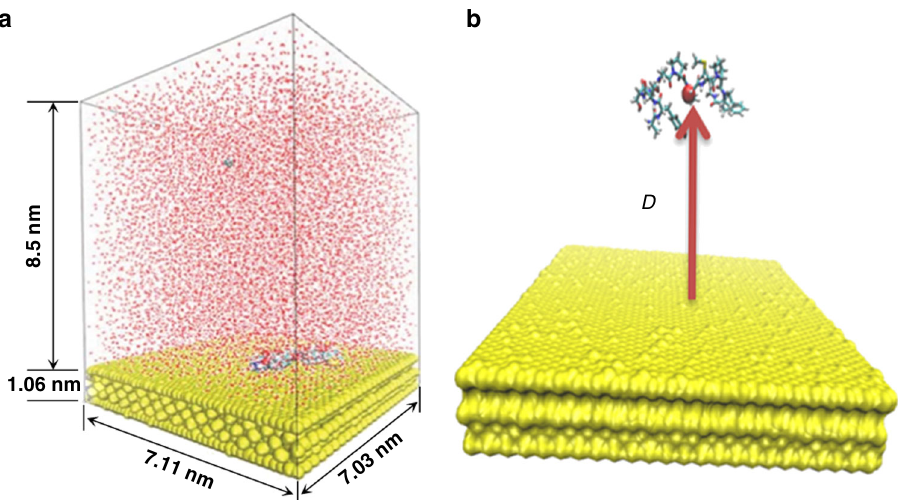
Fig. 6 The simulated system. a Snapshot of the simulated system consisting of water, peptide, one chloride ion and surface; b the distance of the mass center of all alpha carbons in the peptide from a gold surface is chosen as the collective variable in